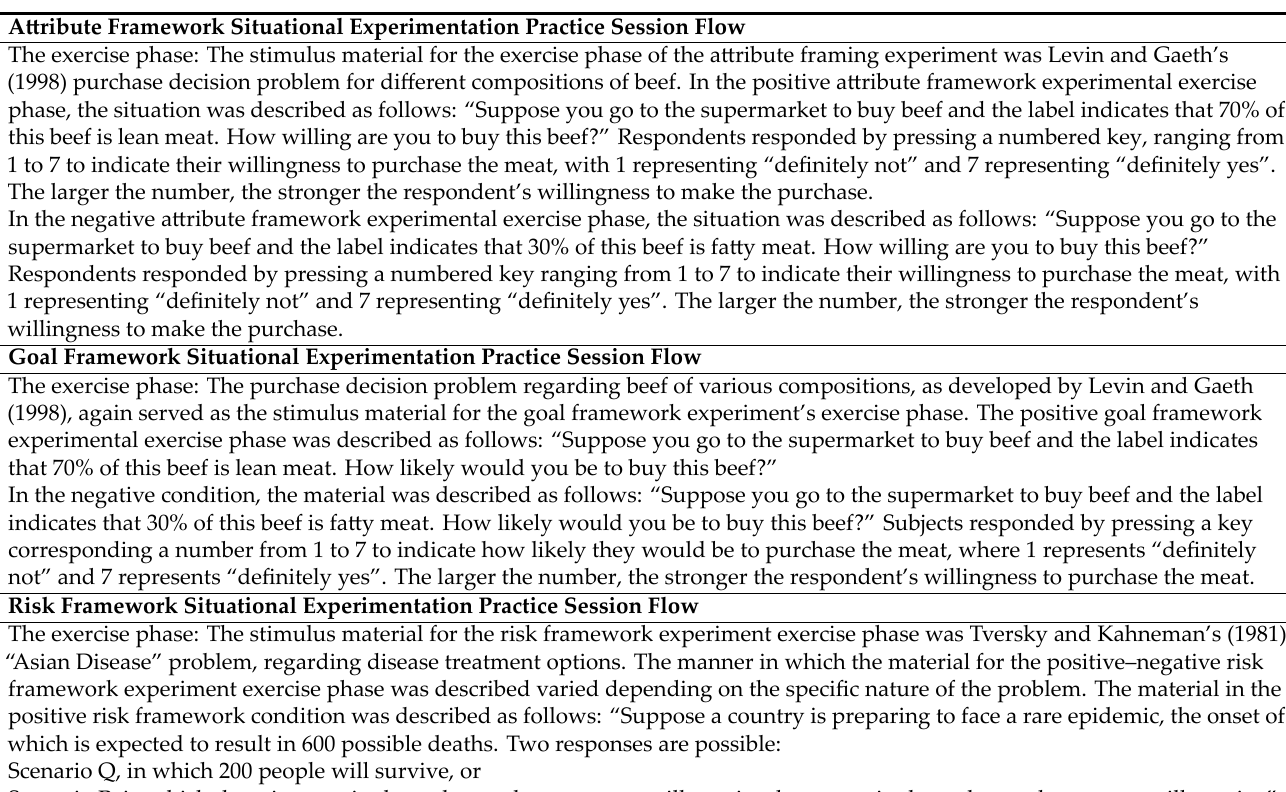
Table A2. Situational experiment practice session stage flow and